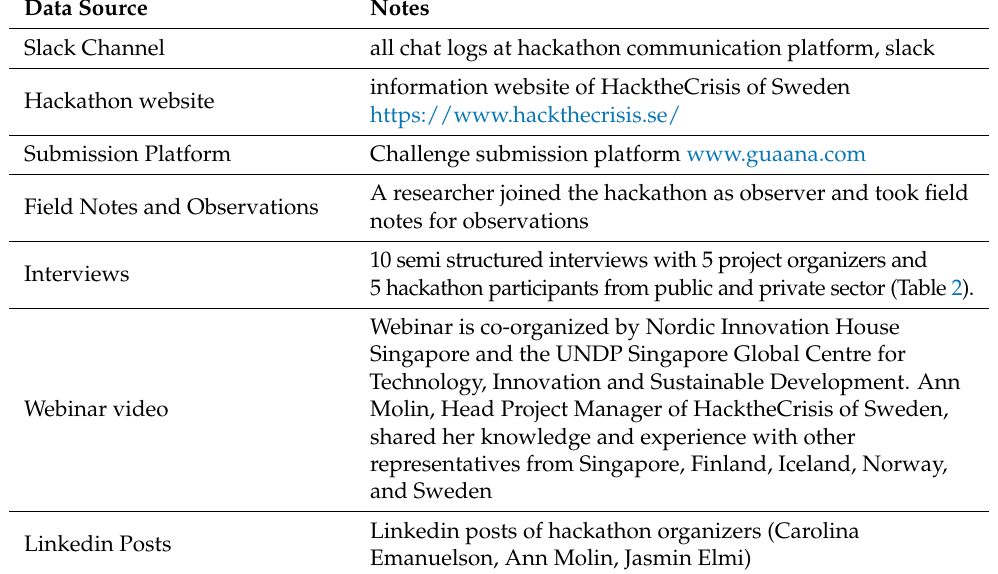
Table 1. Data Sources.